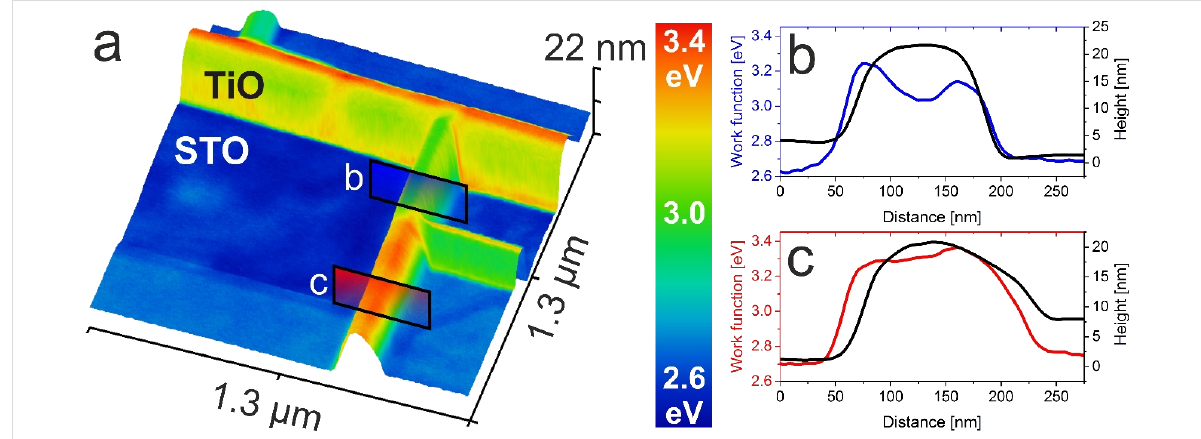
Figure 3: TiO facets influence the work function (WF) on the nanoscale. a) 3D view of the combined topography and the WF of TiO/SrTiO 3 . b,c) To- pography and work function profiles of two areas on the same TiO nanowire.